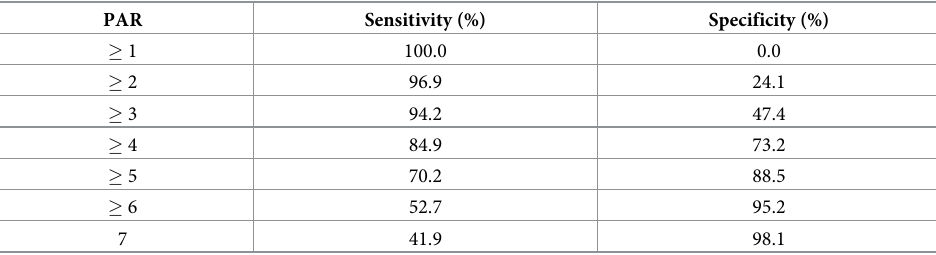
Table 3. Sensitivities and specificities of the composite outcome according to the Patient Acuity